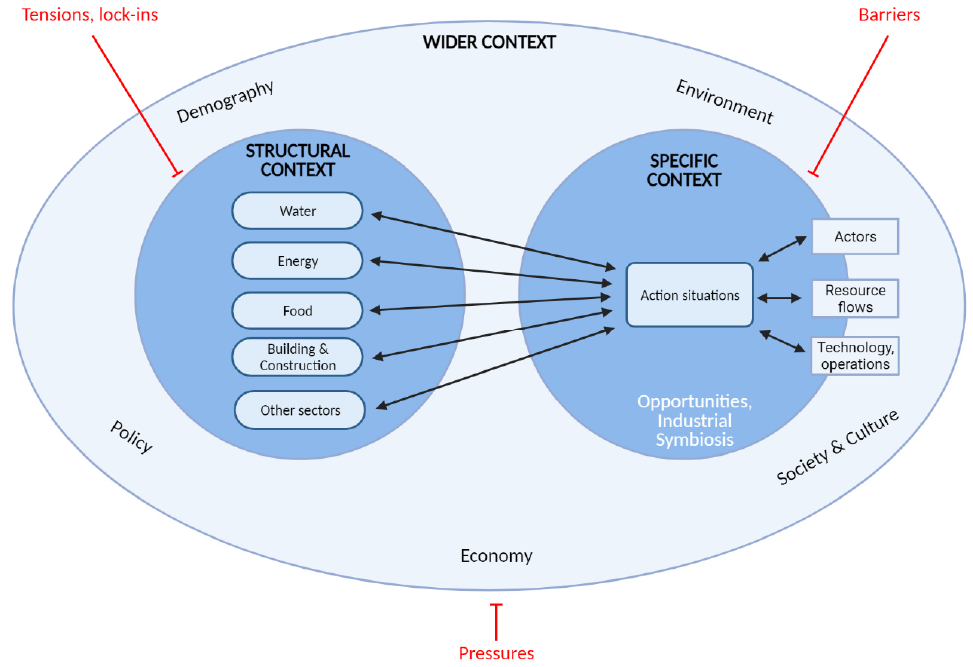
Figure 8. General flow chart for the governance assessment. Relationship between the various levels, key points and existing barriers.